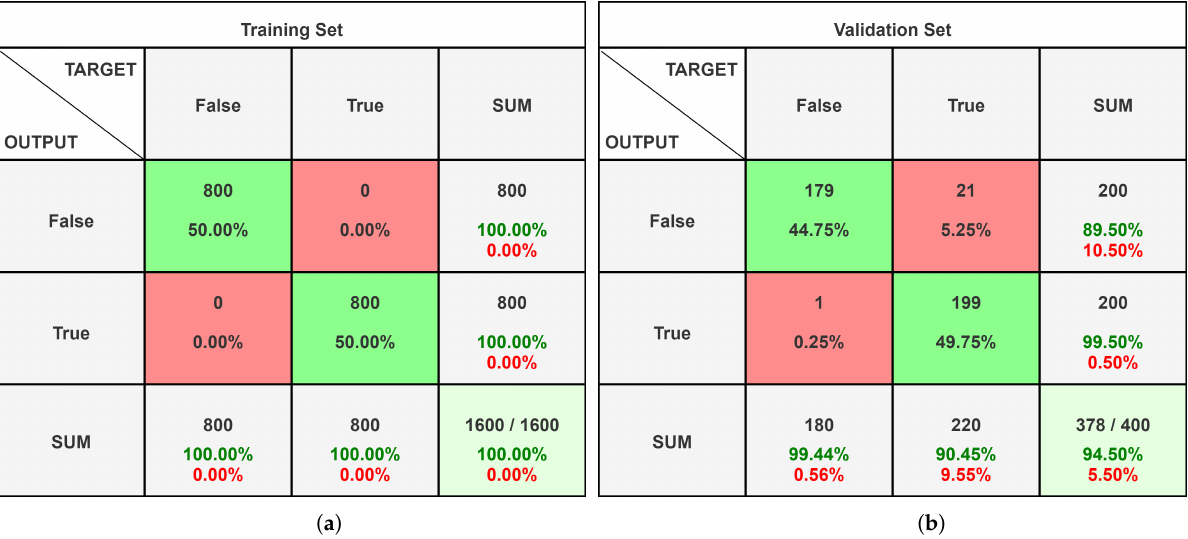
Figure 4. Confusion matrices of the sea dataset analysed on Alexnet with Matlab. ( a ) Training set confusion matrix; ( b ) validation set confusion